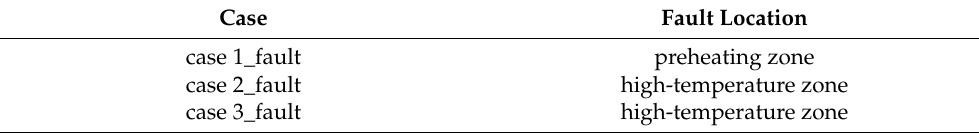
Table 4. Fault location for three cases.